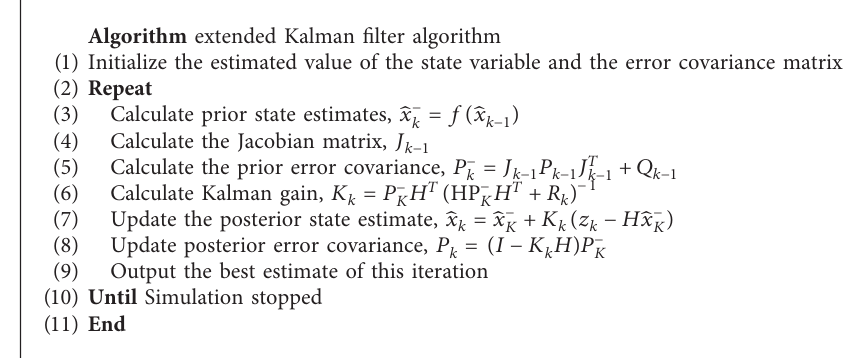
Table 1: Main parameters of the Stewart robot with